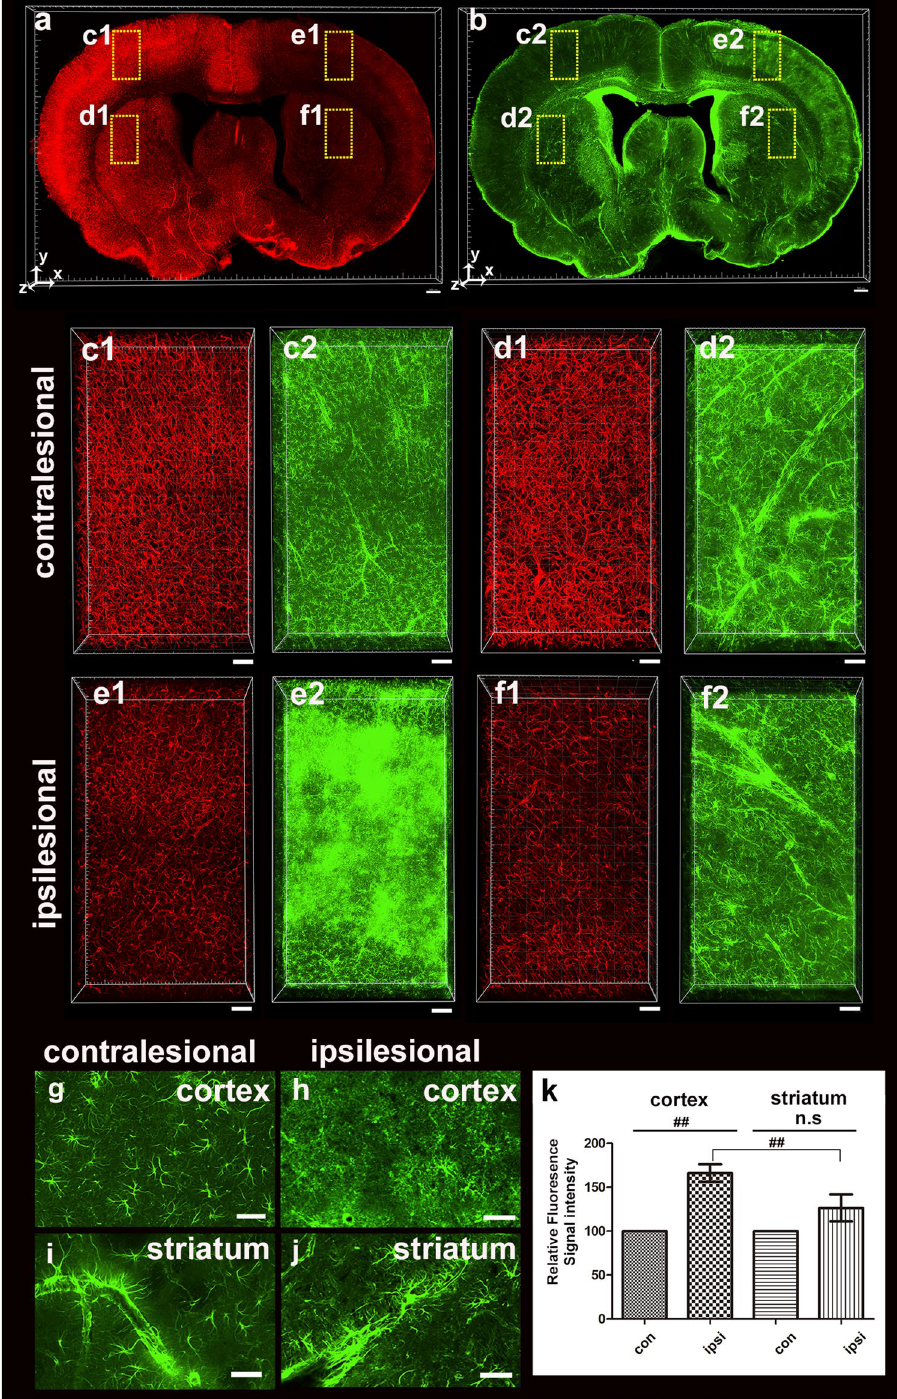
Figure 6. 3D visualization and quantification of GFAP-related immunofluorescence intensities 24 h after MCAO. ( a , b ) 3D reconstruction of the 0.5-mm-thick rat brain slice stained with lectin ( a ) and GFAP ( b ). ( c – f ) Higher-magnification views of the boxed regions in ( a , b ) are shown. A vascular density loss and increased GFAP-positive fluorescence intensity were observed in the ipsilesional cortex compared with the contralateral side. ( g – j ) Morphological change of GFAP-positive cells in the ipsilesional cortex and striatum compared with the contralateral side. ( k ) Graph of the ratio of GFAP-related fluorescence intensity of the ipsilateral versus contralateral cortex 24 h after MCAO injury. GFAP-related fluorescence intensities in the cortex are significantly increased. Data are presented as the mean percentage relative to corresponding contralateral areas ± SEM (measures 3–4 cortical and striatal fields per animal, n = 3 animals). Significant differences were observed in fluorescence intensity of GFAP-positive cells between the contralesional and ipsilesional cortex, but no significant differences were observed between the contralesional and ipsilesional striatums. In addition, significant differences were observed in the fluorescence intensity of GFAP-positive cells between the ipsilateral cortex and the striatum. Paired t-test, FDR multiple comparison test, ## p < 0.05. n.s = no significant differences. Scale bar = 1 mm in ( a and b ), 100 μm in ( c – f ), 50 μm in ( g – j